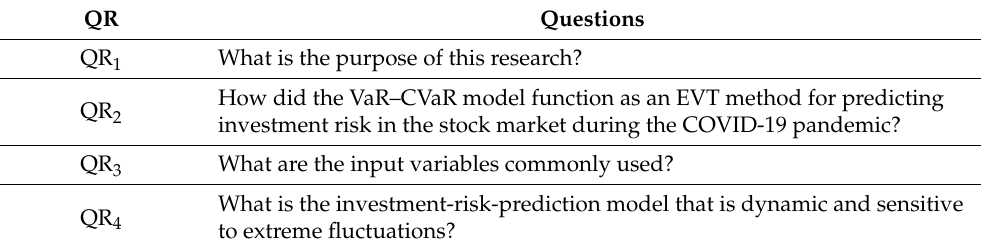
Table 1. Questions research.